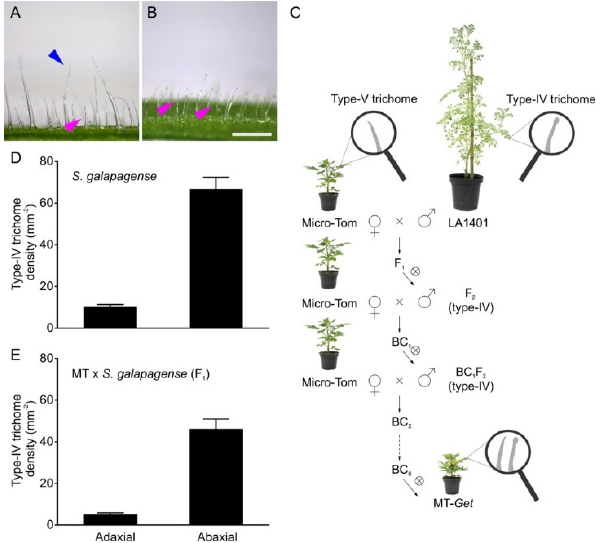
Figure 1. Introgression of Solanum galapagense (LA1401) type-IV trichome trait into cultivated tomato ( S. lycopersicum cv Micro-Tom, MT). Representative light microscopy images showing type-I (blue arrowhead) and type-IV (pink arrowhead) glandular trichomes on the adaxial ( A ) and abaxial ( B ) sides of S. galapagense leaf. Scale bar = 250 μ m. ( C ) Introgression scheme used to create the Micro-Tom (MT) genotype bearing type-IV trichomes on leaves of the adult developmental phase. The genotype was designated “ Galapagos enhanced trichomes ” ( Get ). ⊗ = self-pollination, BC =